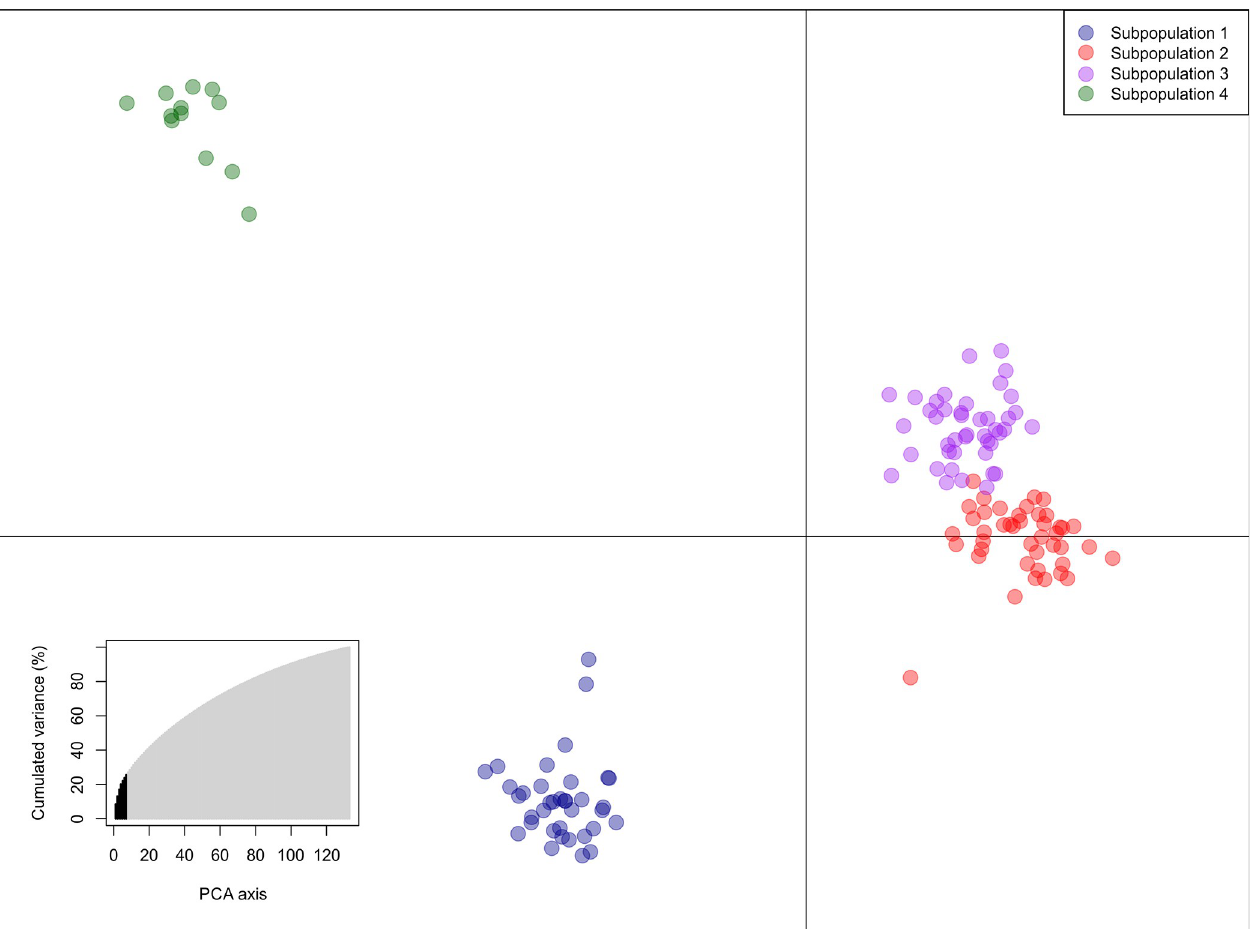
Fig 2. DAPC for the BPSG. The axes represent the first two linear discriminants (LD). The dots represent accessions grouped in subpopulations, each with a different color. The cumulative variance values, in percentages, of the PCs are shown in the lower left corner of the figure; the eigenvalues of the seven first PCs retained by PCA are in